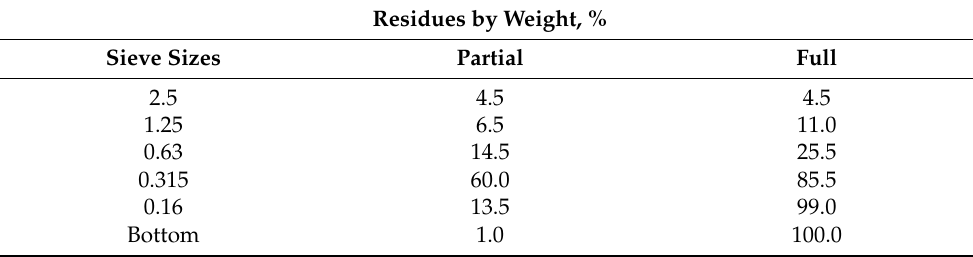
Table 2. Granulometric composition of natural quartz sand. Residues by Weight,